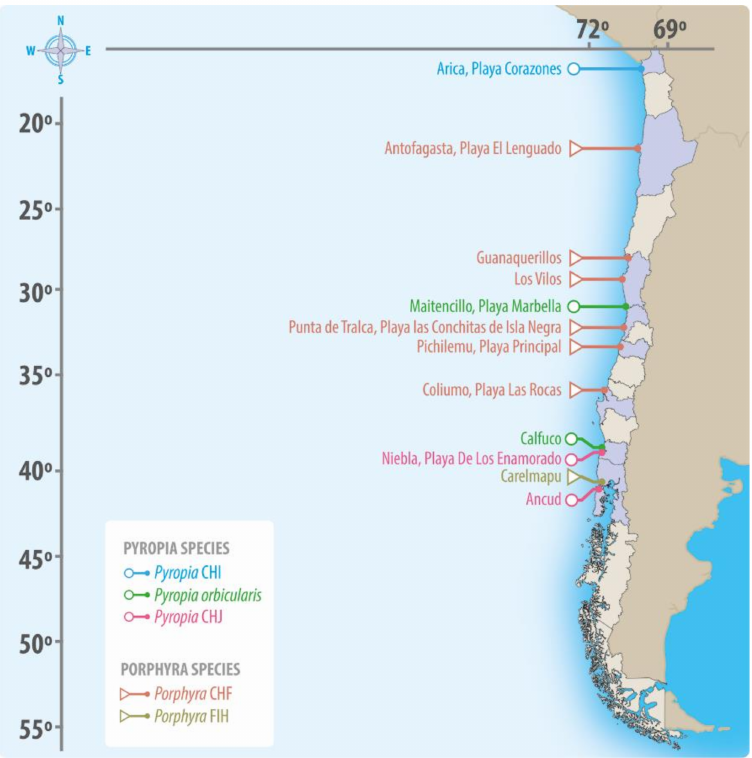
Figure 6. Sampling sites along the Chilean coast of the Porphyra and Pyropia species studied in this